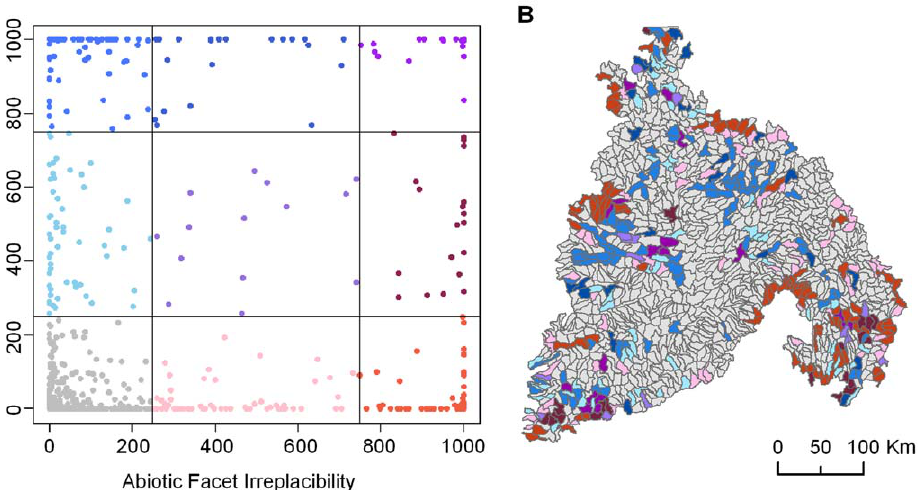
Figure 6. Scatterplot of irreplaceability. Irreplaceability is measured as the number of times a planning unit was selected across 1000 potential networks. The plot shows the irreplaceability of planning units for representing bioidiversity elements plotted against the irreplaceability of planning units for representing abiotic facets. The solid lines indicate divisions for low irreplaceability (i.e., selected in less than 250 solutions) or high irreplaceability (i.e, selected in more than 750 solutions) (A). The map displays the spatial location and irreplaceability values of planning units in the Columbia Plateau ecoregion corresponding to irreplaceability values for both target types (B). Blue planning units have high irreplaceability for biodiversity elements, red planning units have high irreplaceability for abiotic facets, and intermediate purple planning units have high irreapleacbility for both. Grey planning units are not important in representing either type of conservation element.